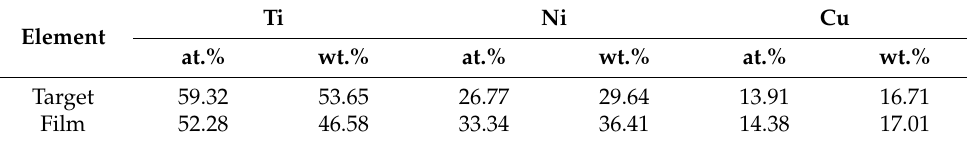
Table 3. Comparative compositional analysis of the Ti-Ni-Cu target and film.